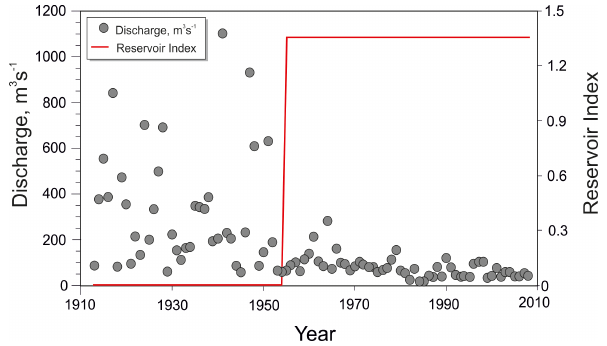
Figure 6. Variations of the RI in the Aranjuez gauge station. Note the sharp change in RI value produced in 1957.